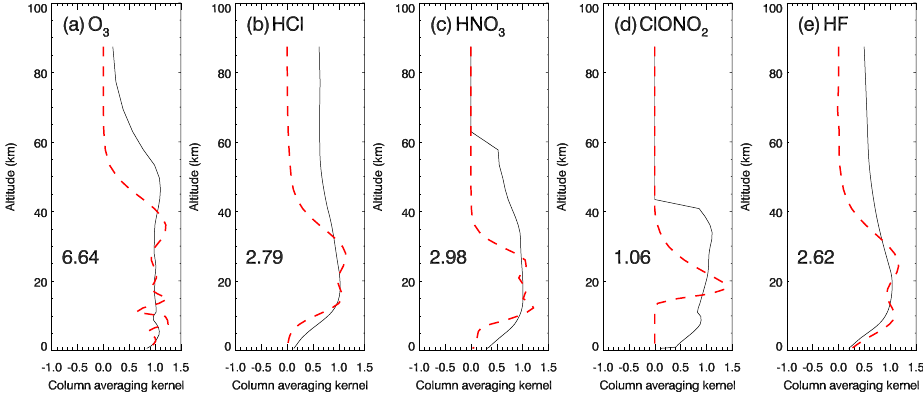
Fig. 1. Typical column averaging kernels (black solid line) and sensitivities (red dashed line) for the 125HR springtime measurements (calculated for 6 March 2009 at a solar zenith angle of 85.58 ◦ ).